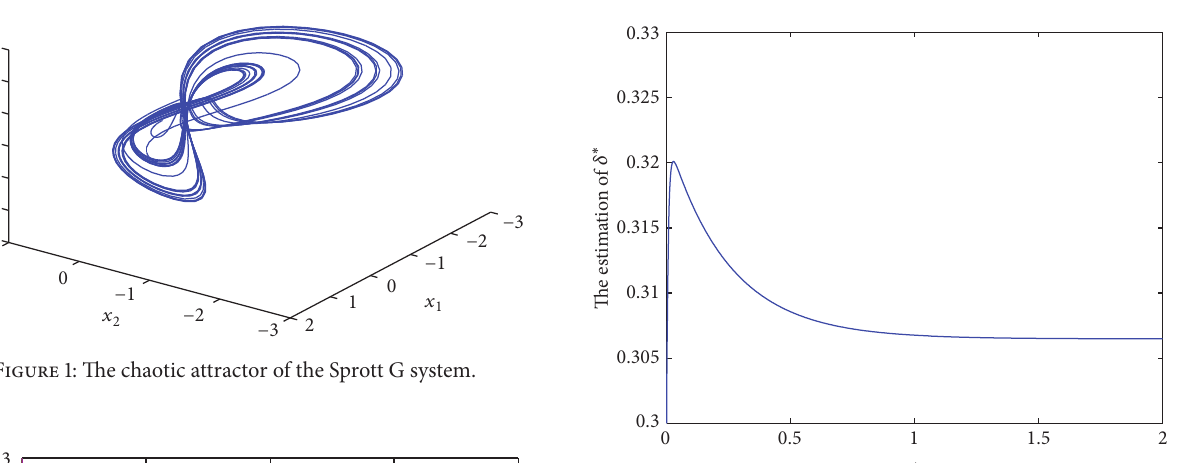
Figure 3: The curve of estimation